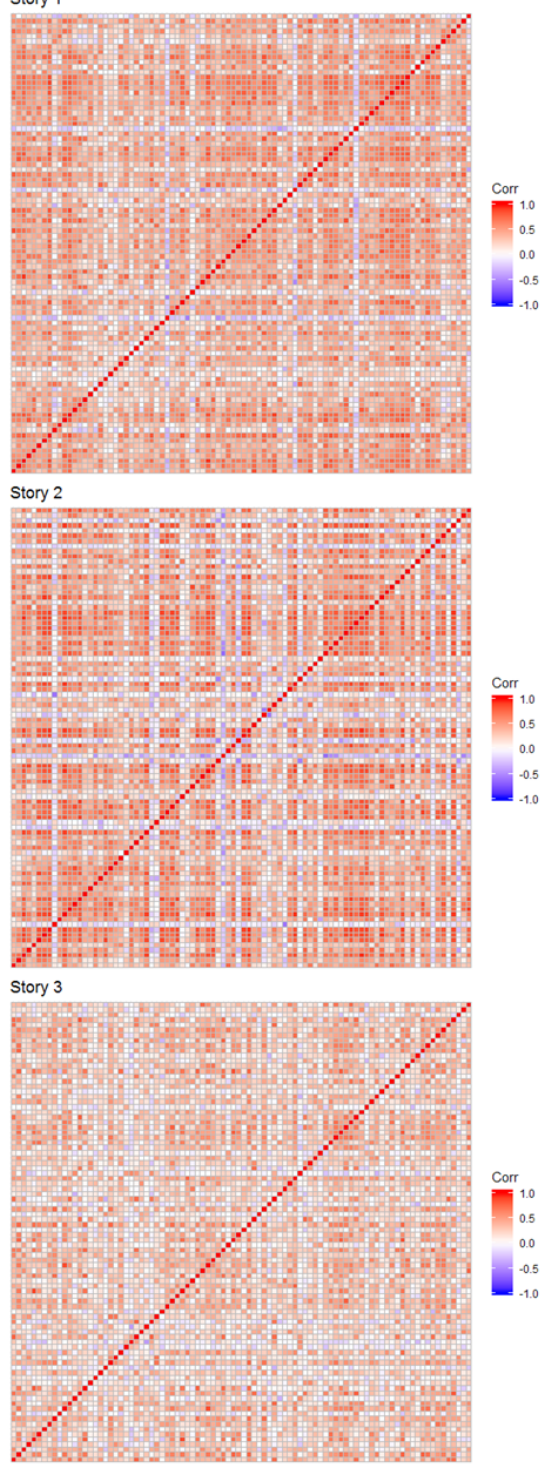
Figure 1. Correlation matrices for each story. Cells represent cor- relations between all possible subject pairs. The figure presents that correlation matrix when skipped words values were ex- cluded. The matrices show that there is considerable spread in how (dis)similar participants are in their gaze duration pattern. The diagonal of the correlation matrix represents the correlation of each participant with themselves (correlation r = 1.00). Red means positive, blue negative correlations.